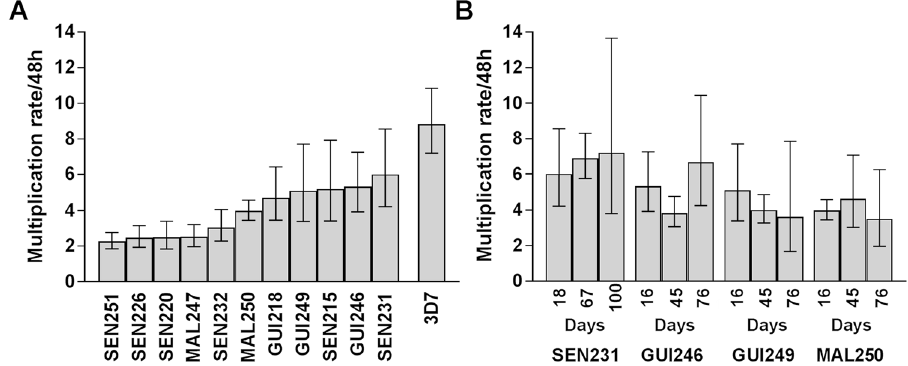
Figure 3. Parasite multiplication rates (with 95% confidence intervals) of new P. falciparum clinical isolates, sampled from patients in three West African countries (GUI, Guinea; SEN, Senegal, MAL, Mali). ( A ) Eleven isolates were analysed after growth in culture for at least two weeks (between 16 and 32 days) prior to assay. Exponential growth was measured over 4 days using a general linear model approach. All assays were conducted with biological triplicates in separate flasks with different donor erythrocytes, except for SEN232 which was assayed in duplicate. Six of the isolates (SEN232, GUI246, MAL247, GUI249, MAL250, SEN251) were assayed in medium supplemented by Albumax and serum, whereas the other five were assayed by medium with Albumax alone as noted in the Materials and Methods (results were similar for the two groups, Mann- Whitney test P = 0.90). As a control, the laboratory adapted clone 3D7-HT-GFP (here labelled ‘3D7 ′ ) was tested in parallel in each assay, yielding a consistent multiplication rate of approximately 8 fold per 48 hours. ( B ) Four of the clinical isolates cultured for longer periods were assayed at three different time points after culture initiation (up to 76 or 100 days for each isolate). These showed no significant changes in multiplication rate over time in culture. Assays were conducted with biological triplicates, except for the last cultured time point for which the assay was conducted in